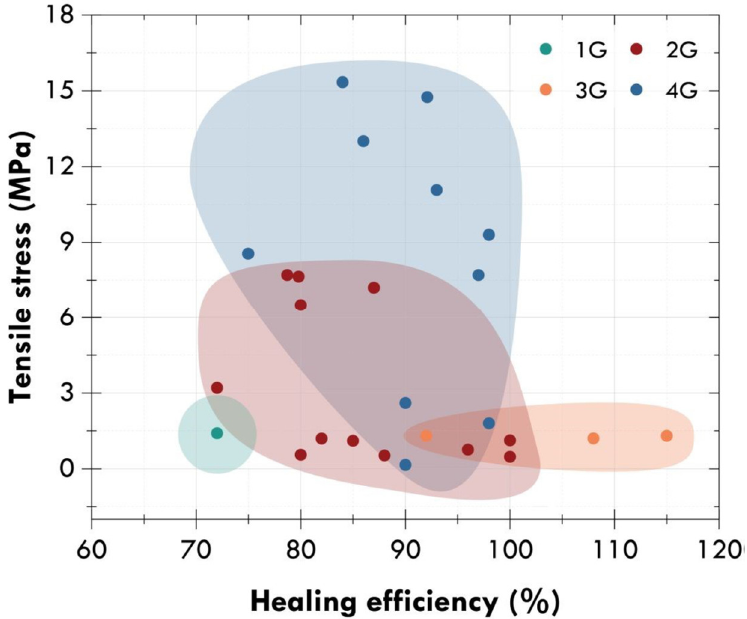
Figure 20. Diagram of four generations (G) of self-healing elastomers. Reproduced from Ref. [215] with permission from the Royal Society of Chemistry.